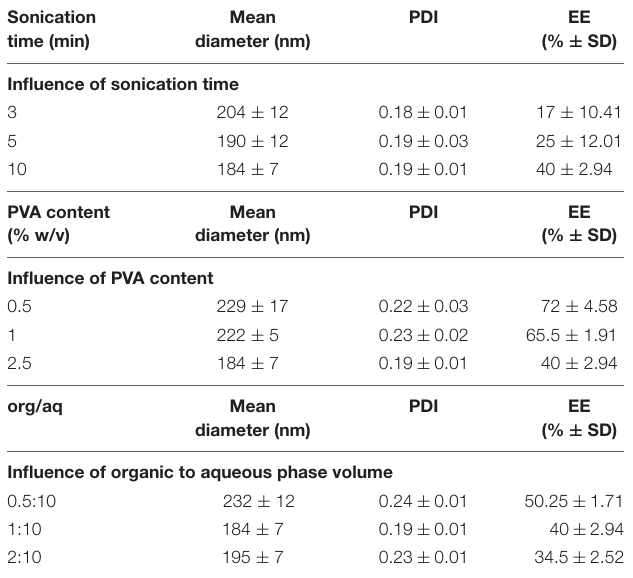
TABLE 1 | Comparison of particle size, PDI and EE of Rho-loaded PLGA NPs prepared by varying different parameters.